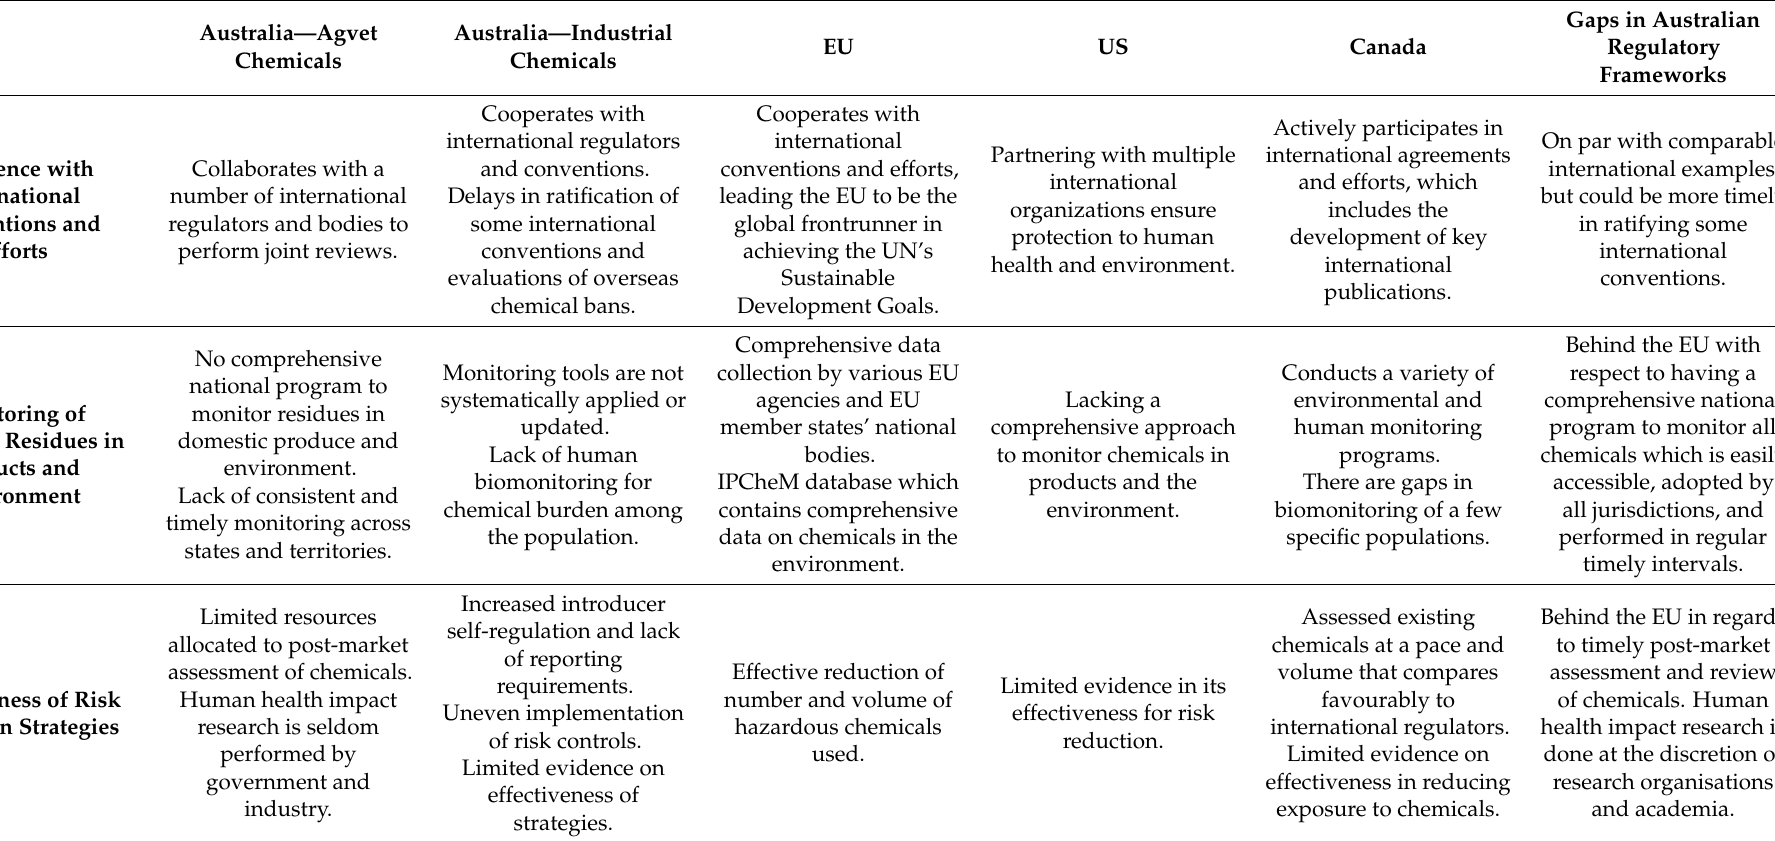
Table 1. Comparison of Australian and comparative international chemical regulatory frameworks in the EU, US, and Canada across seven different criteria, including gaps identified in the Australian